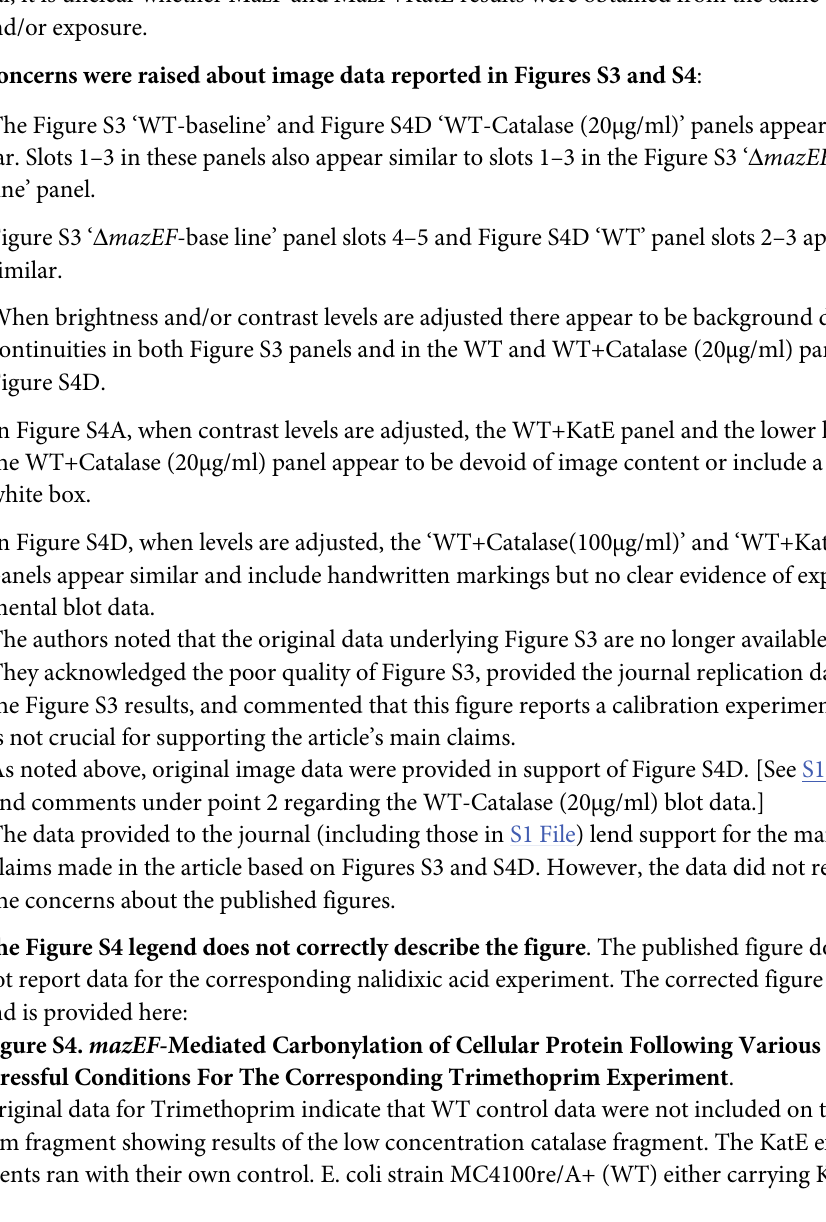
Figure S4. mazEF -Mediated Carbonylation of Cellular Protein Following Various Stressful Conditions For The Corresponding Trimethoprim Experiment